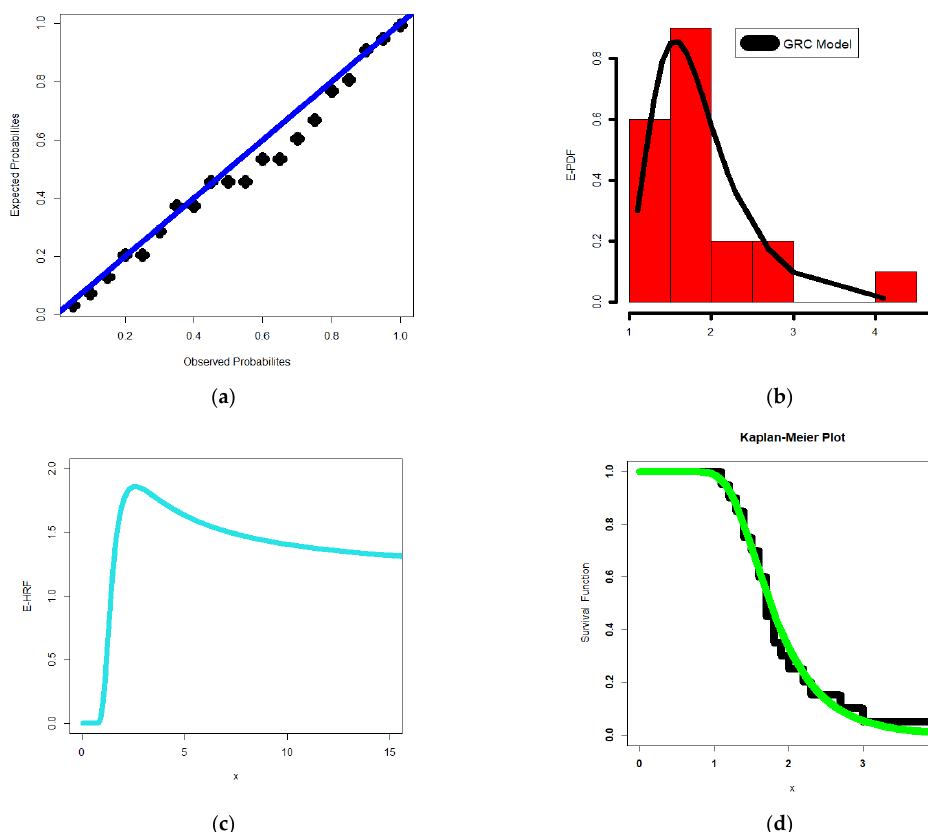
Figure 6. The P – P ( a ); E-PDF ( b ); E-HRF ( c ); Kaplan – Meier plot ( d ); for the relief times data. Figure 6. The P–P ( a ); E-PDF ( b ); E-HRF ( c ); Kaplan–Meier plot ( d ); for the relief times